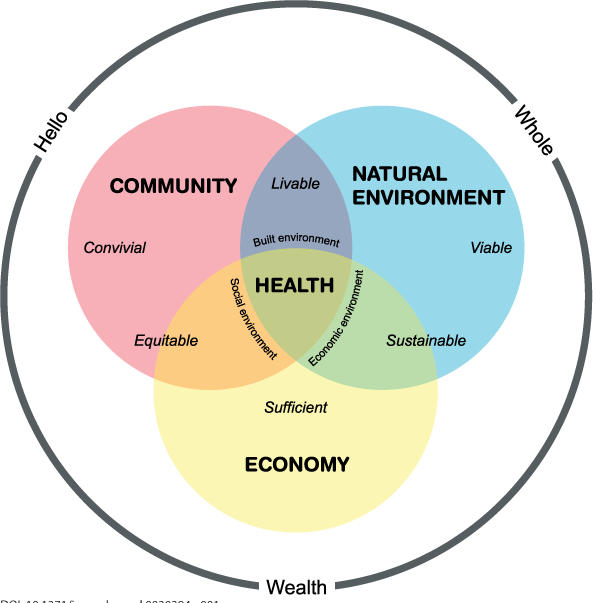
Labonté's 1993 Description of a Holosphere of Healthy Communities, with Health at the Centre (Derived from [8]).The interacting environmental spheres include a viable and sustainable natural environment and a sustainable economy.